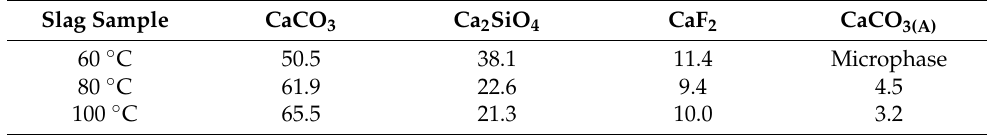
Table 4. Main mineral phase composition of carbonated AOD slag.